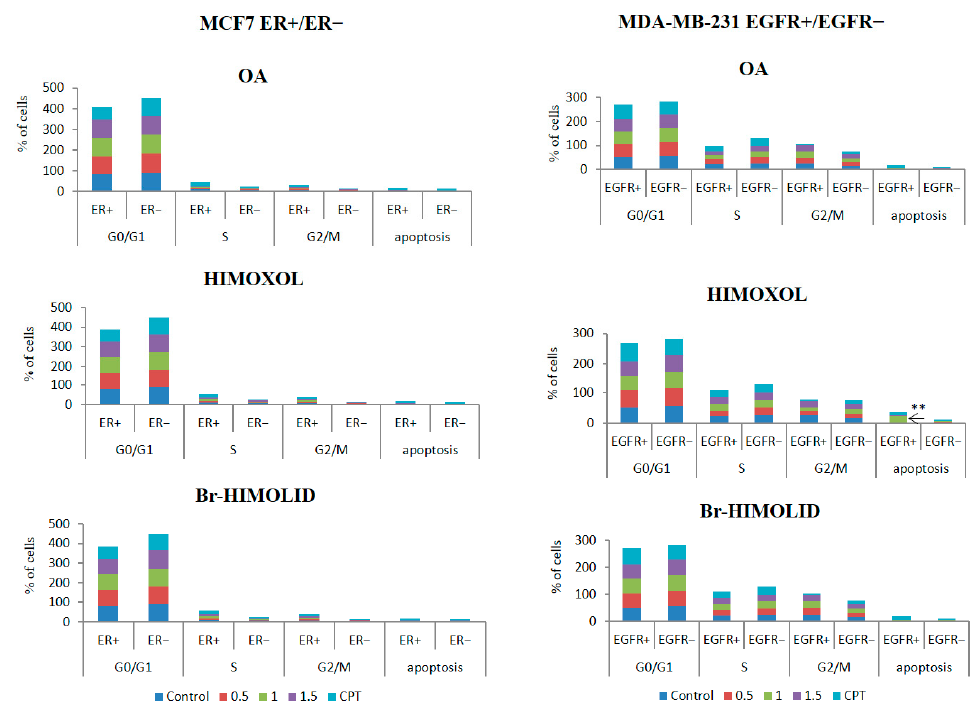
Figure 4. Evaluation of cell cycle modulation and proapoptotic potential of OA or its derivatives. MCF7 and MDA-MB-231 cells (ER+/ − and EGFR+/ − , respectively) were treated with studied compounds and 0.5 × , 1 × , or 1.5 × IC 50 values were applied. Camptothecin (CPT, 5 µ M for MCF7 and 20 µ M for MDA-MB-231) was used as a positive control. The mean value of three experiments ± SD is shown: ** p < 0.05. Cell cycle cytofluorimetry data analyses for MCF7/ER+ and MDA-MB-231/EGFR+ cells were published before [30,31].